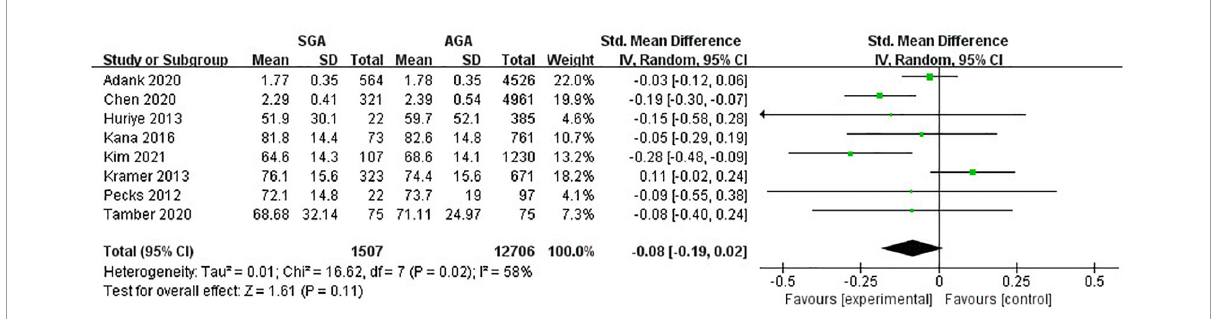
FIGURE5 Forest plot exploring the association between maternal TG levels and delivery of SGA. HDL-C, high-density lipoprotein-cholesterol; SGA, small for gestational